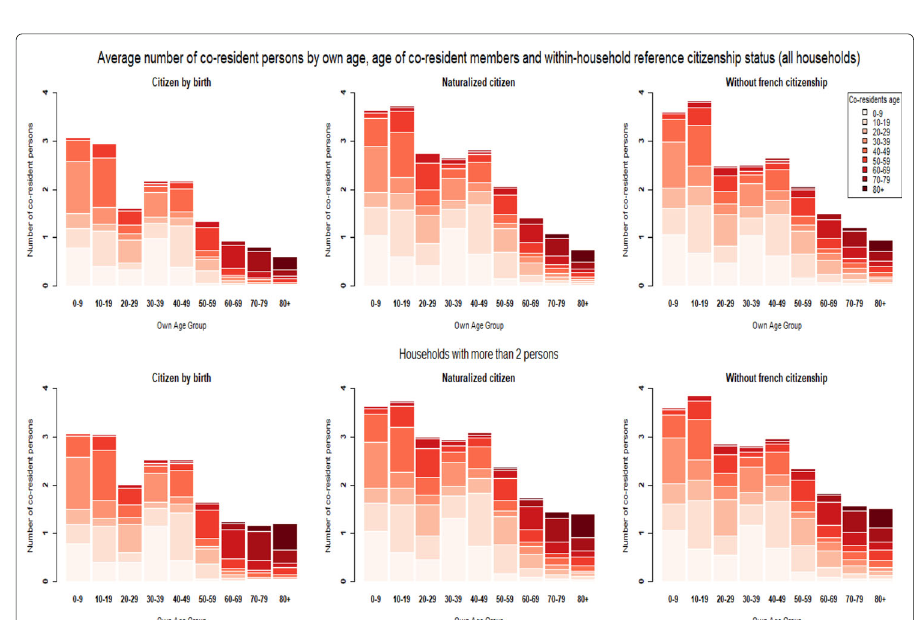
Fig. 7 Household structures by head-of-household citizenship